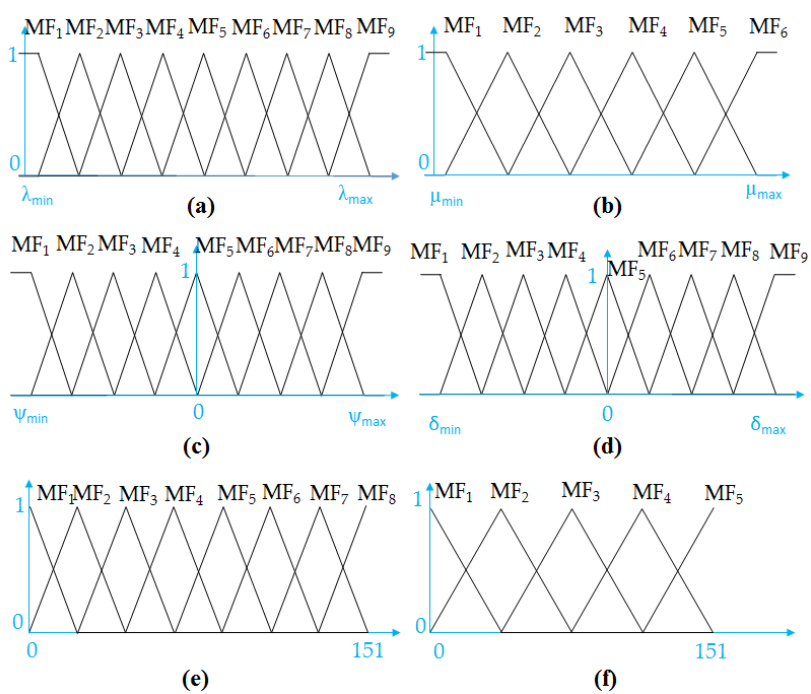
Figure 5. Fuzzy logic controller membership functions: ( a ) ABS λ input; ( b ) ABS μ x input; ( c )